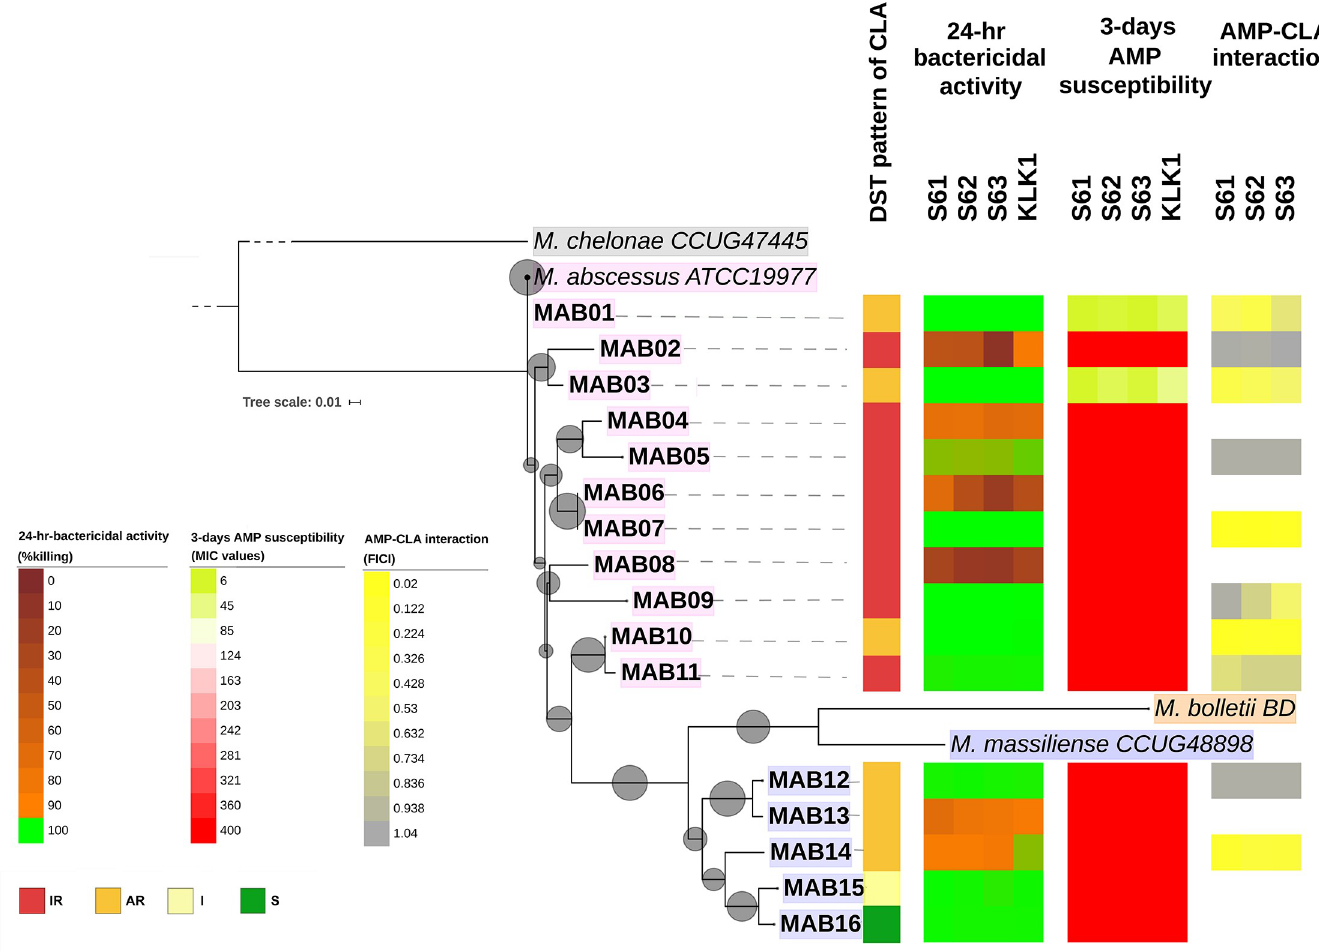
Fig 3. The phylogeny of M . abscessus and clarithromycin/ AMPs susceptibility patterns. A whole genome-based tree of 1,000 bootstraps from 3,180 SNPs is shown. The sequences of reference strains M . chelonae CCUG47445, M . abscessus subsp. abscessus ATCC19977, M . abscessus subsp. bolletii BD, and M . abscessus subsp. massiliense CCUG48898 were included without phenotypic results. Ten clinical isolates as representatives from the phylogenetic tree including inducible and acquired resistance of two Mab subspecies were selected for the AMP-clarithromycin interaction assay. AR, acquired resistance; CLA, clarithromycin; DST, drug susceptibility testing; FICI, fractional inhibitory concentration index; I, intermediate; IR, inducible resistance; MIC, minimum inhibitory concentration; S, susceptible.